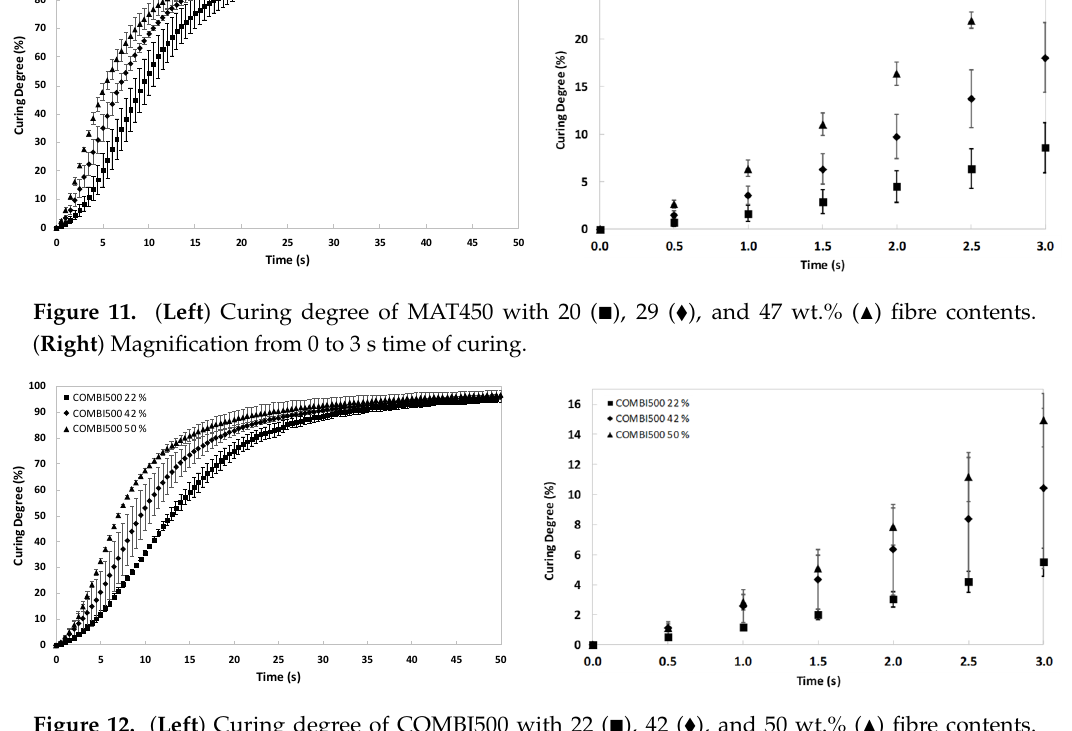
Figure 12. ( Left ) Curing degree of COMBI500 with 22 ( ■ ), 42 ( ♦ ), and 50 wt.% ( ▲ ) fibre contents. ( Right ) Magnification from 0 to 3 s time of curing.